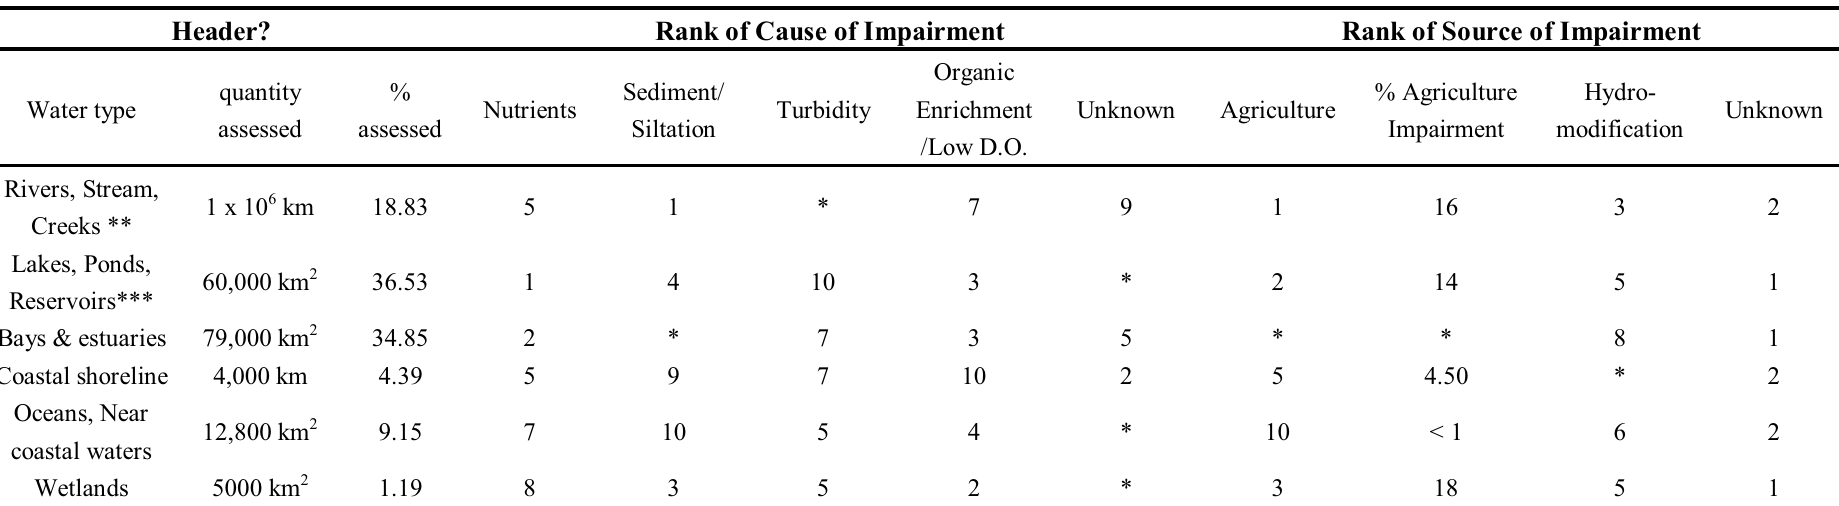
Table 1. Causes and Sources of Impairment of US Waters related to agriculture and drainage modification. Adapted from EPA, 2002. See text in Section 2.1 for more recent rankings for streams and lakes (EPA 2009).